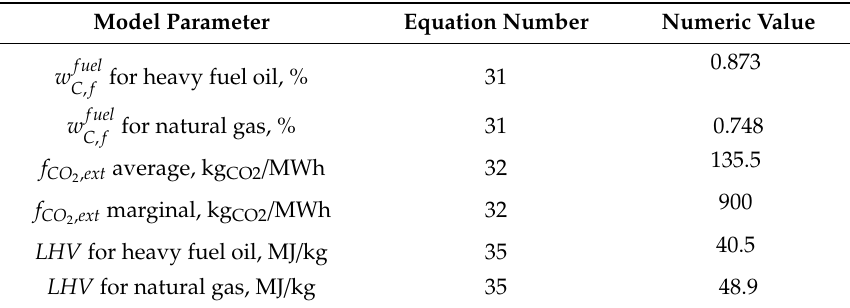
Table 7. Model inputs for CHP unit and assessment of CO 2 emissions